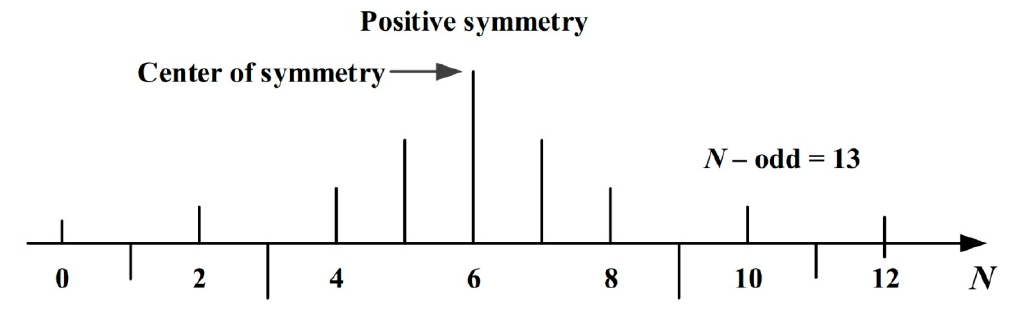
Figure 2. The symmetric impulse response of the non-recursive 13th order DF.